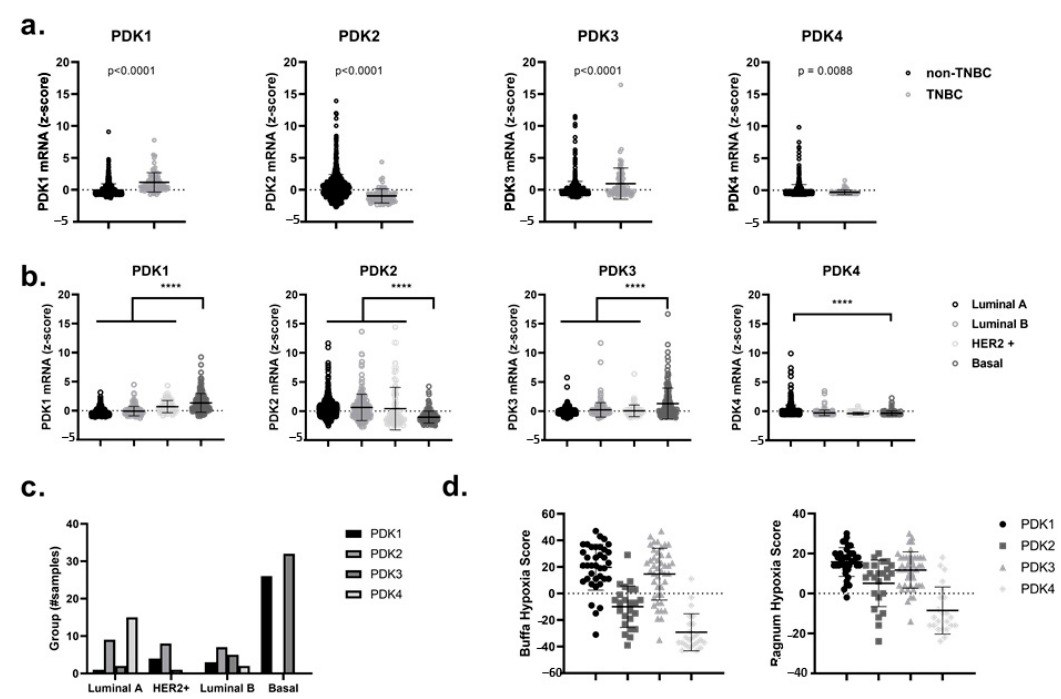
Figure 1. Upregulated mRNA expression for PDK1 and PDK3 correlates to hypoxia-related gene signatures in triple-negative and basal-like breast cancers. ( a ) PDK1–4 mRNA expression (RNA-seq) in non-triple-negative breast cancer (non-TNBC) subtype vs. TNBC cases. ( b ) PDK1–4 mRNA expression (RNA-seq) in different breast cancer subtypes classified by the Pam50 classification of the TCGA dataset (luminal A, luminal B, HER2+ and Basal). ( c ) Number of samples in TCGA dataset that have a z ‐ score of z > 2 for PDK1–4 in different breast cancer subtypes classified by the Pam50 classification system. ( d ) The Buffa hypoxia score (left) and the Ragnum hypoxia score (right) correlates with the overexpression ( z >2) of PDK1–4 mRNA . **** p < 0.0001.